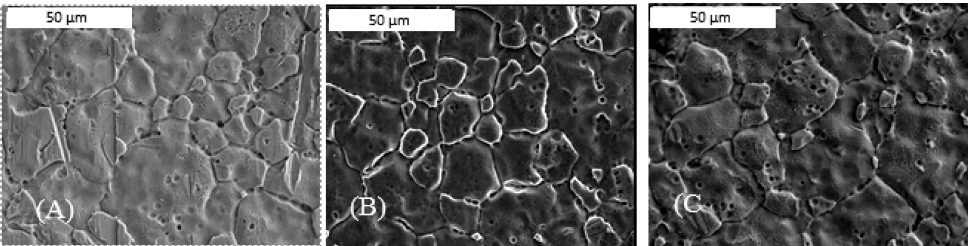
Figure 8. The microstructures of Nimonic 263, recorded by SEM: ( A ) base material; ( B ) laser treated material with 1064 nm, 50 pulses, 10 mJ (power density 3.3 GW/cm 2 ); and ( C ) laser treated material with 532 nm, 50 pulses, 25 mJ.